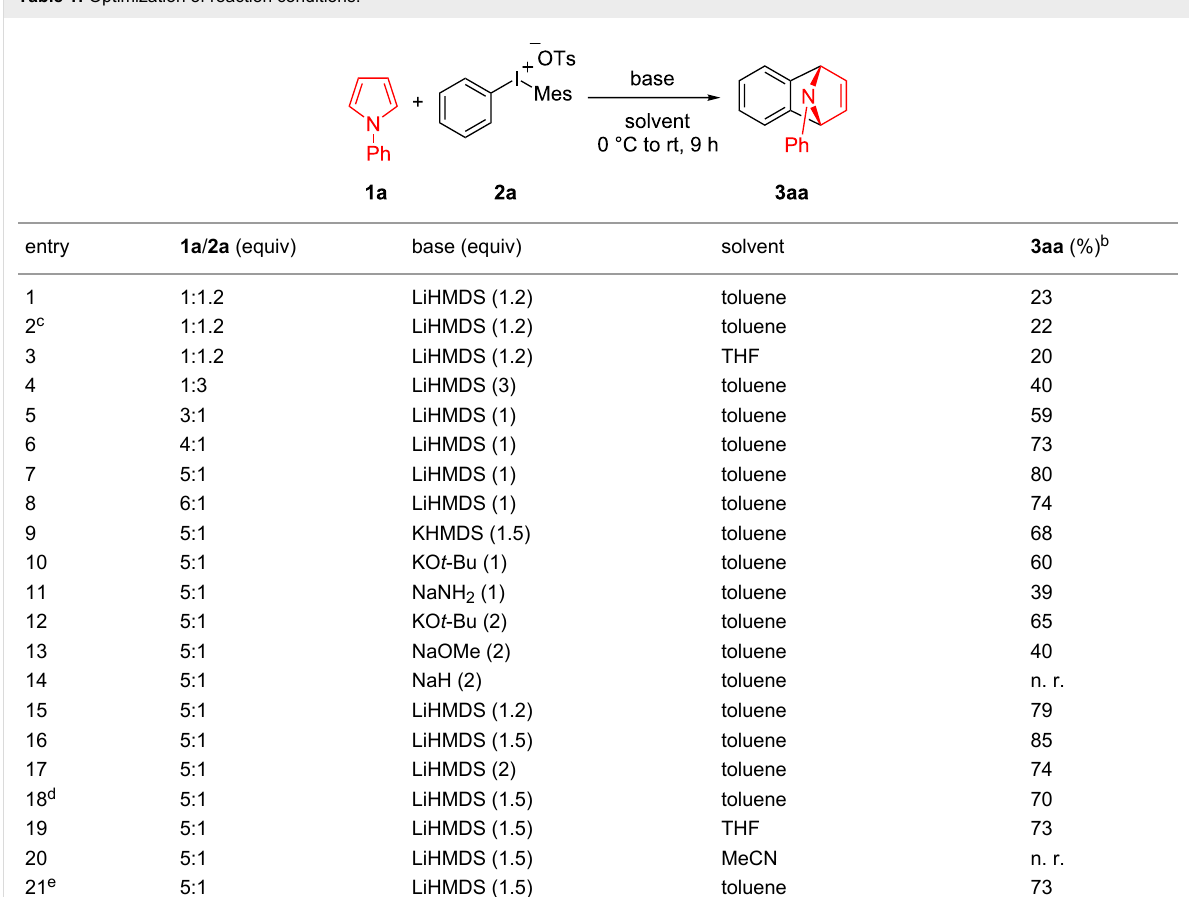
Table 1: Optimization of reaction conditions.